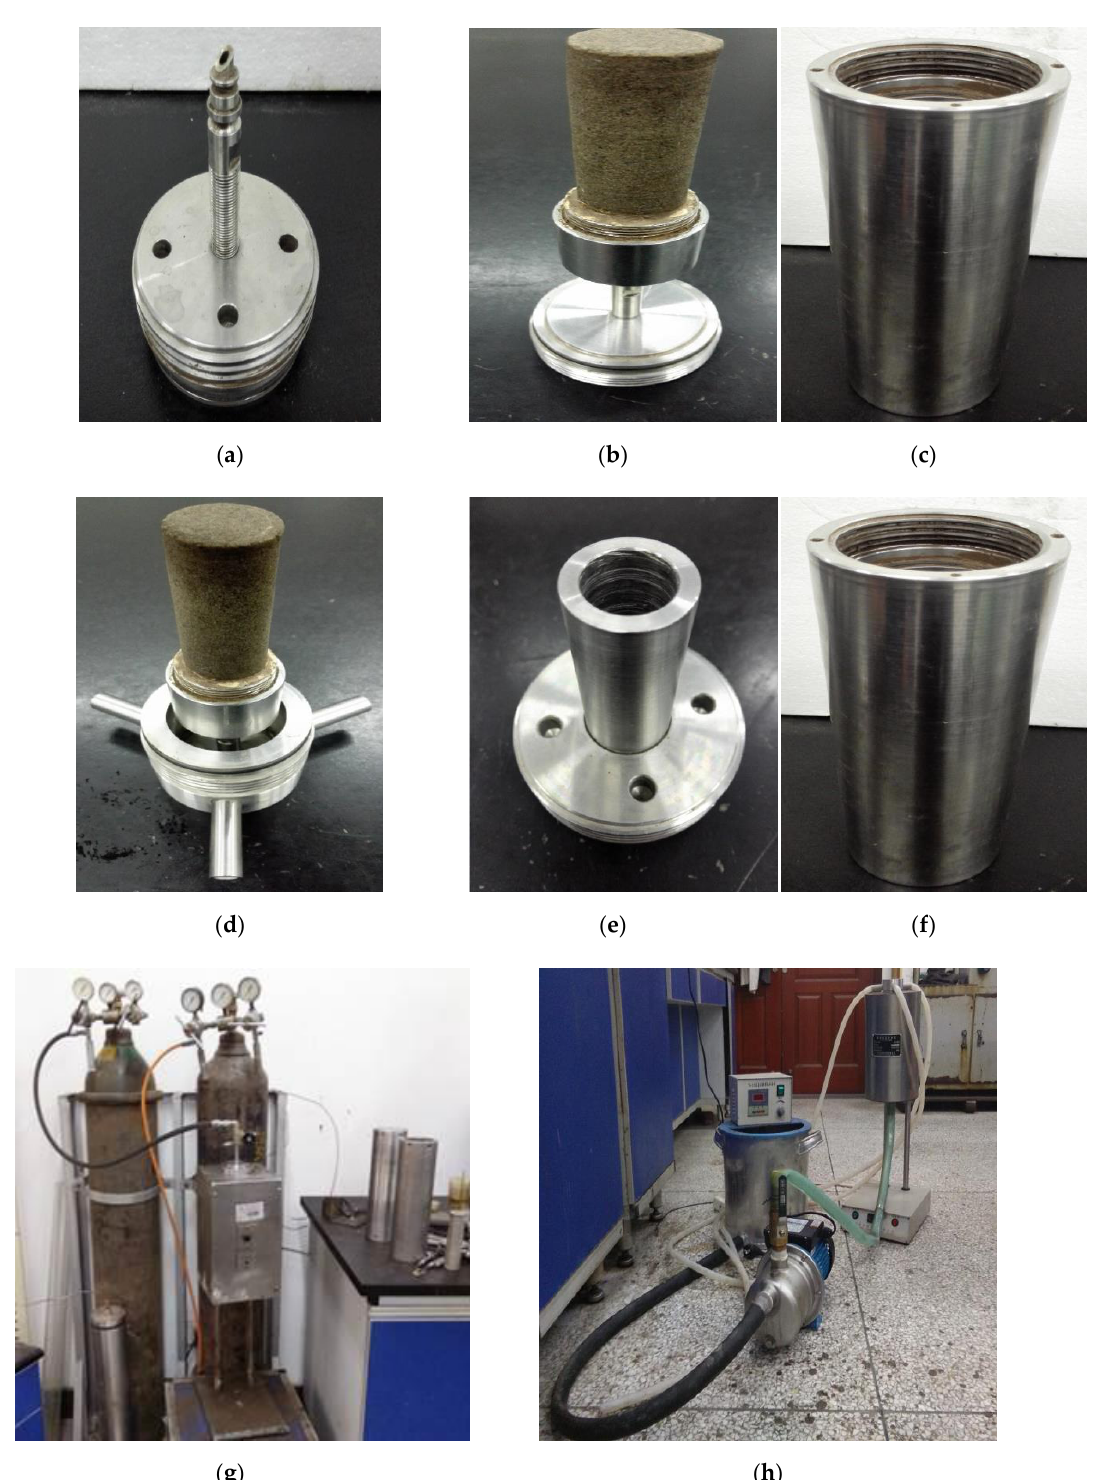
Figure 3. Physical diagram of mud cake forming device and flushing device. mud cake forming device:( a ) is device cover,( b )is device lower cover,( c ) is device outer, （ h ） is high-temperature and high-pressure filter; flushing device:( d )is device cover,( e )is device lower cover,( f )is device outer,( i ) is physical drawing of flushing device.